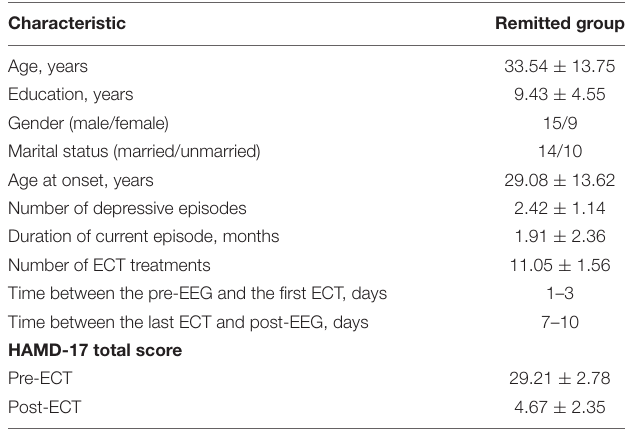
TABLE 1 | Demographic variables and clinical characteristics of patients with